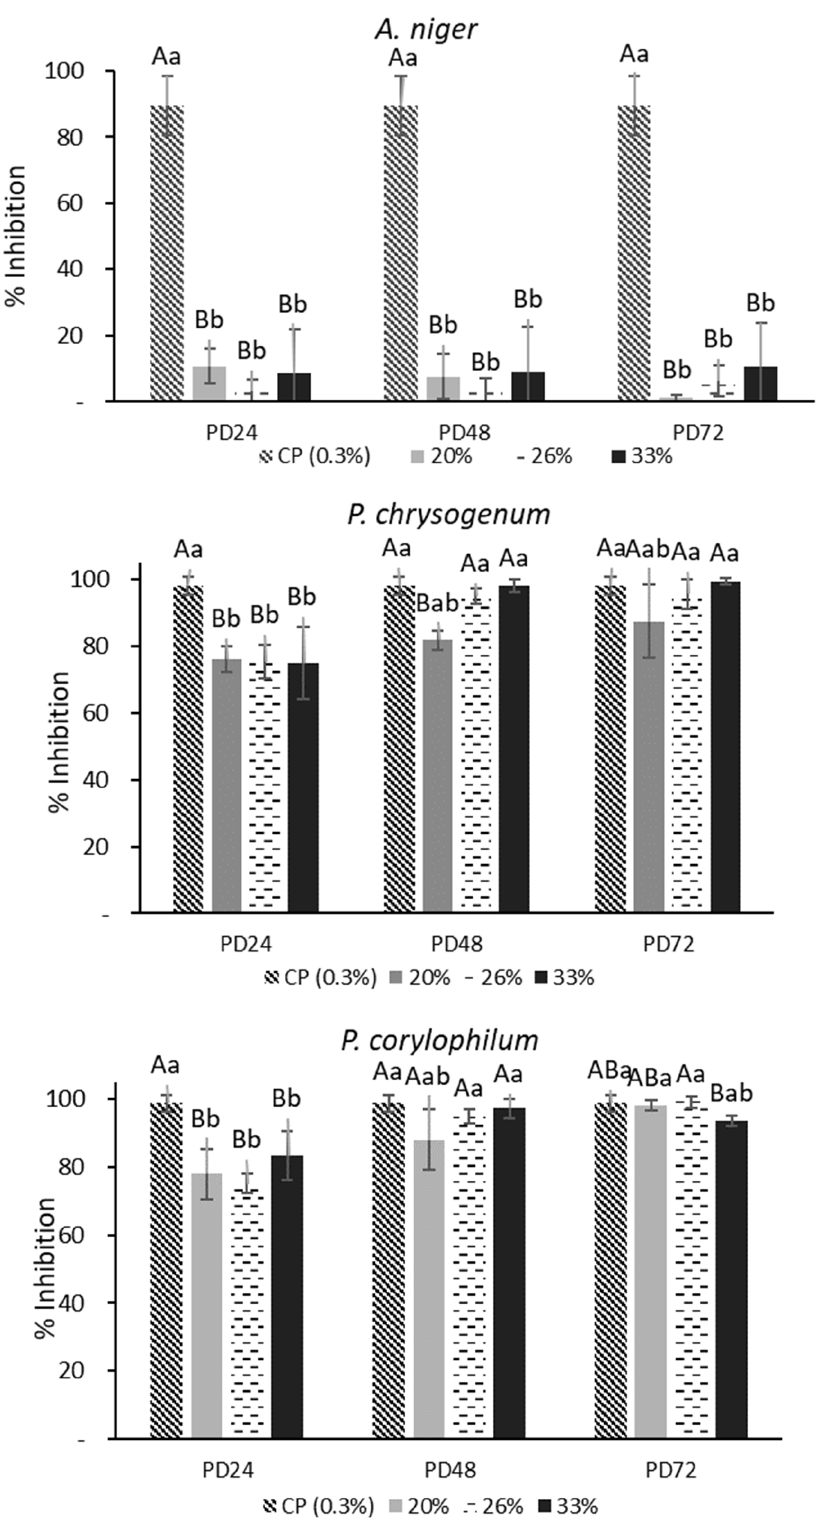
Figure 1. Percentage of inhibition (plate counts) of aqueous extracts (AEs) obtained from the poolish-type dough (PD) fermented with Lactiplantibacillus plantarum NRRL B-4496 for 24, 48, and 72 h at three concentrations and calcium propionate (CP). Different capital letters show significant differences ( p < 0.05) with respect to the fermentation time. Lowercase letters indicate significant differences ( p < 0.05) with respect to the concentration of AEs at the same fermentation time.